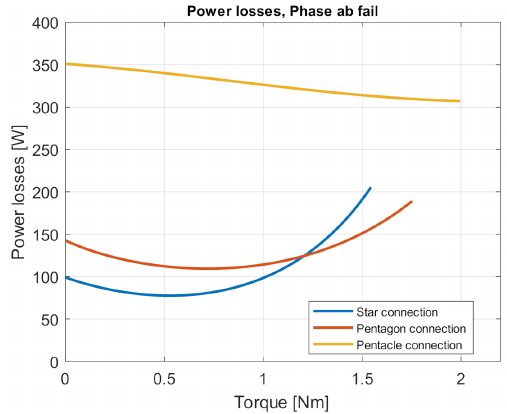
Figure 16. Motor losses, phase failure ab, U IN = 5 × 230 V, 50